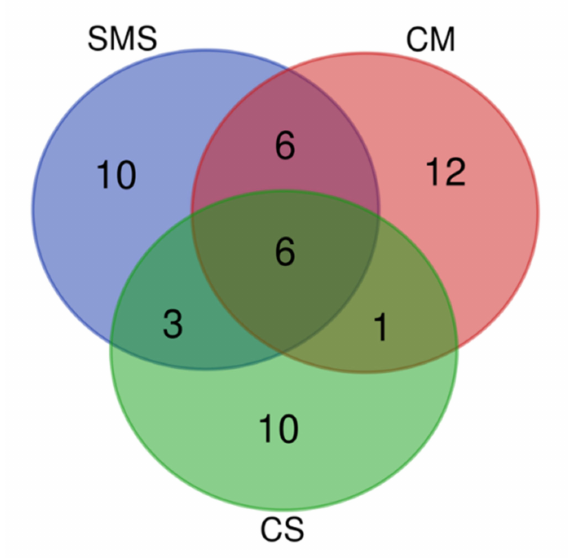
Figure 8. Venn diagram of fungal species in soil treatments, showing the number of shared and unique species in the treatments based on identified operational taxonomic units (OTUs) ≥ 1%. The numbers in the overlapping circles show the species shared by two or three treatments of the fungal community and the intersections of the circles indicate the coexisting fungal genera in those treatments. SMS—spent mushroom substrate, CM—chicken manure, CS—control